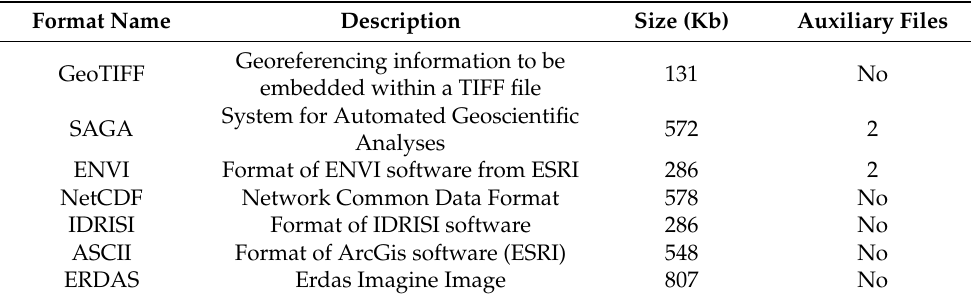
Table 1. File size of the different raster formats for the QPE field as of 9 September 2012.